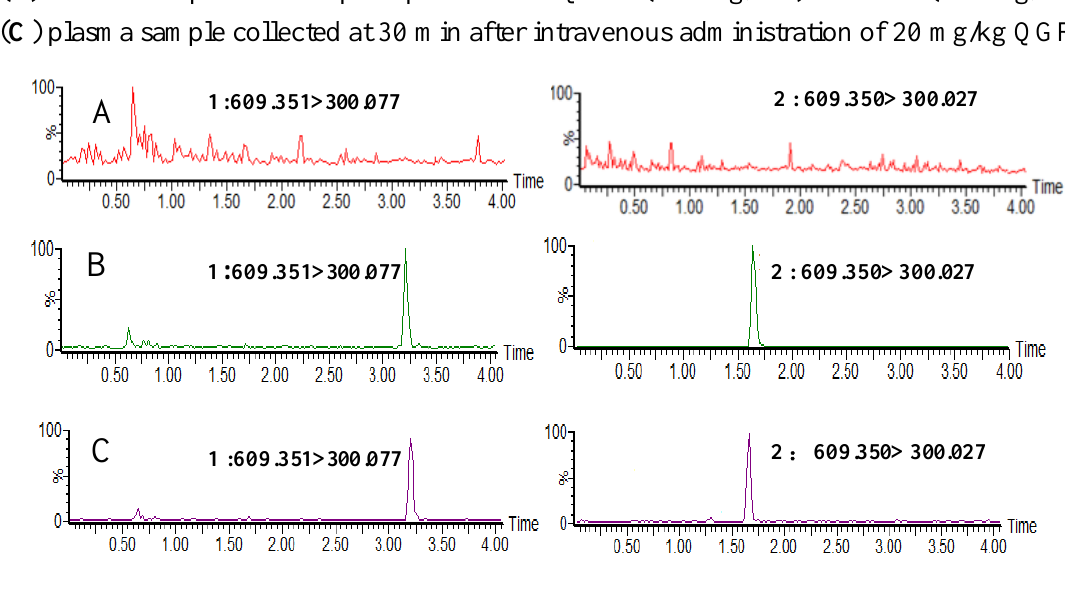
Figure 1. Representative chromatograms for QGR ( 1 ) and IS ( 2 ) in ( A ) rat blank plasma; ( B ) blank rat plasma sample spiked with QGR (740 ng/mL) and IS (500 ng/mL); ( C ) plasma sample collected at 30 min after intravenous administration of 20 mg/kg QGR.